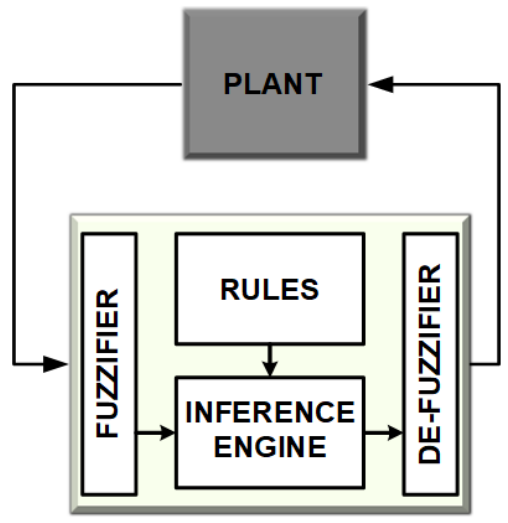
Figure 3. Fuzzy controller